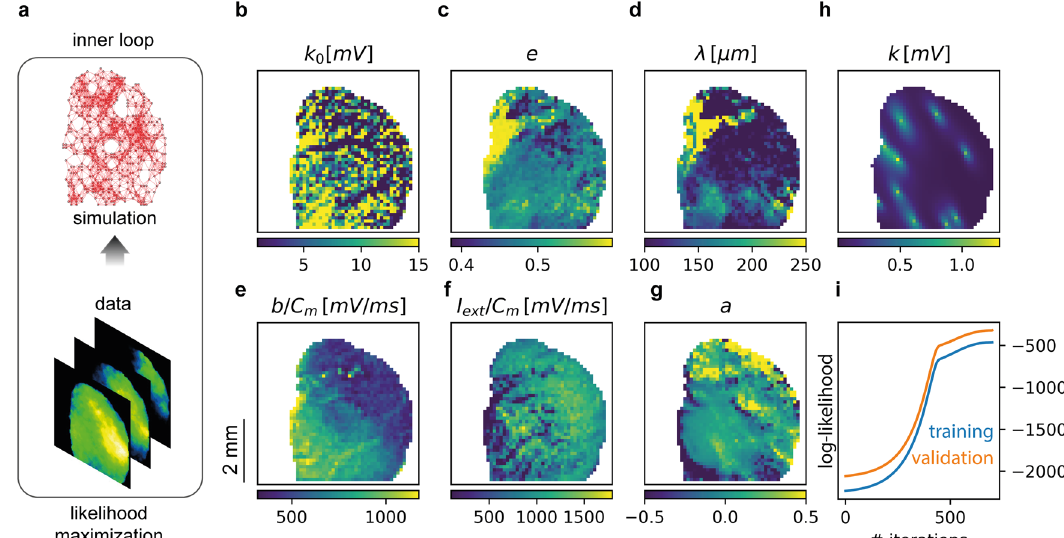
Fig. 3 Inner Loop. a The inner loop: likelihood maximization. b – g Spatial maps of estimated parameters after 700 iterations of iRprop 80 , that we further improved by setting priors for the expected spatial decay law of lateral connectivity. Parameters k 0 , e , λ , and a are the connectivity parameters (weight, eccentricity, spatial scale, and anisotropy), as de fi ned in Methods; I ext and b are the local external input and the strength of the spike frequency adaptation. h Ten inferred elliptic connectivity kernels k , presented in an overlayed manner, that illustrate the existence of strong eccentricity e for the elliptic connectivity kernels. i . Training and validation log-likelihoods (in blue and orange, respectively) as functions of the number of iterations.